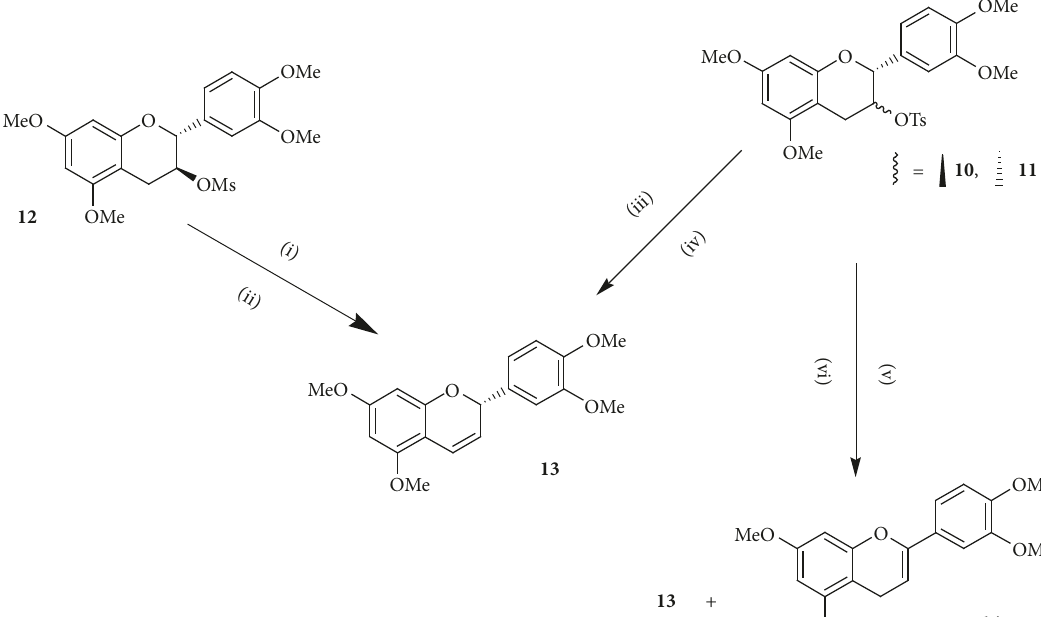
Scheme 3: Synthesis of flavenes. Reagents and conditions: (i) 12 , LDA, THF, ice bath, 15%; (ii) 12 , DBU, MeCN, reflux, 99%; (iii) 10 , LDA,